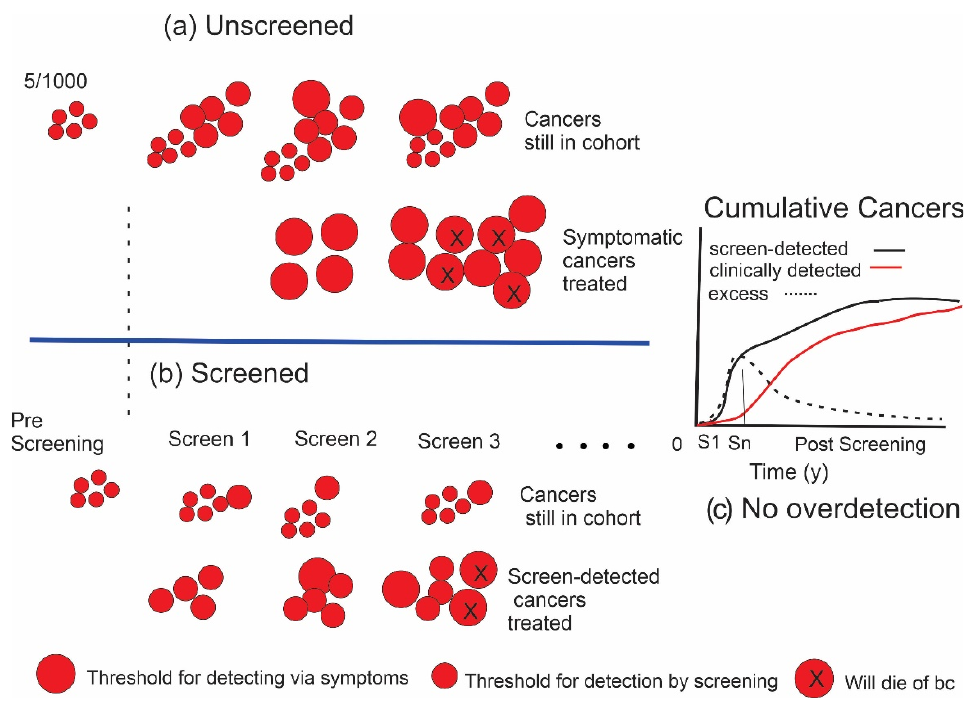
Figure 1. ( a ) Illustrates the initiation and growth of breast cancers in an unscreened population (e.g., 1000 women). Size of the lesion is represented by the diameter of the discs. X indicates cancers that will result in death. ( b ) The effect of screening. In ( a , b ), the lower rows indicate cancers that have been detected and treated, while upper rows show cancers in the cohort that have not yet been detected. ( c ) Difference (excess) in the cumulative number of cancers found in screened (black curve) versus unscreened (red curve) individuals, depicted in the graph as the dashed line, increases during the period of screening. In this example where there is no overdetection, cancers are found and treated earlier in the screened group; however, after screening ends at Sn, the number in the unscreened group will catch up over time, eliminating the excess.